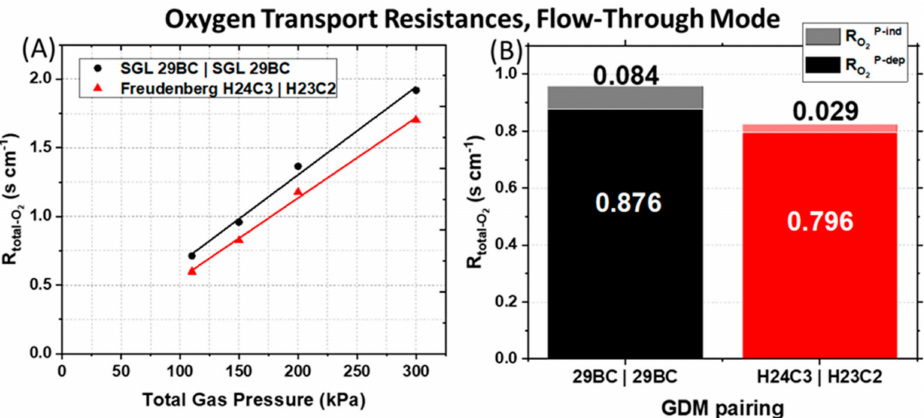
Figure 4. ( A ) Total O 2 transport resistance (R total-O ) calculated from Equation (1) as a function of 2 total gas pressure. ( B ) Total O 2 transport resistance calculated for the 150 kPa abs back-pressure data = sum of the solid and shaded bars) which can be separated into pressure dependent set (R total-O 2 P-dep ) and pressure independent (R P-ind ) terms as described by Equation (R O O 2 2